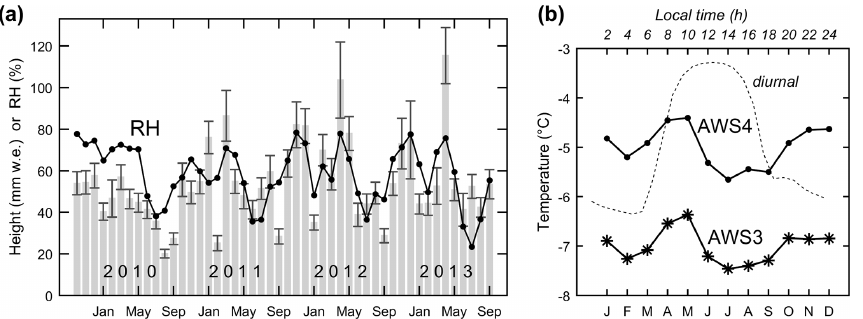
Figure 4. (a) Monthly accumulation totals (bars) and mean monthly relative humidity (line) at AWS4 and (b) mean annual cycle of air temperature at both AWSs and the associated mean diurnal cycle at AWS4 (dashed line and upper x axis) between 8 October 2009 and 30 September 2013. Error bars in (a) are from the sonic ranger data processing (Sect.